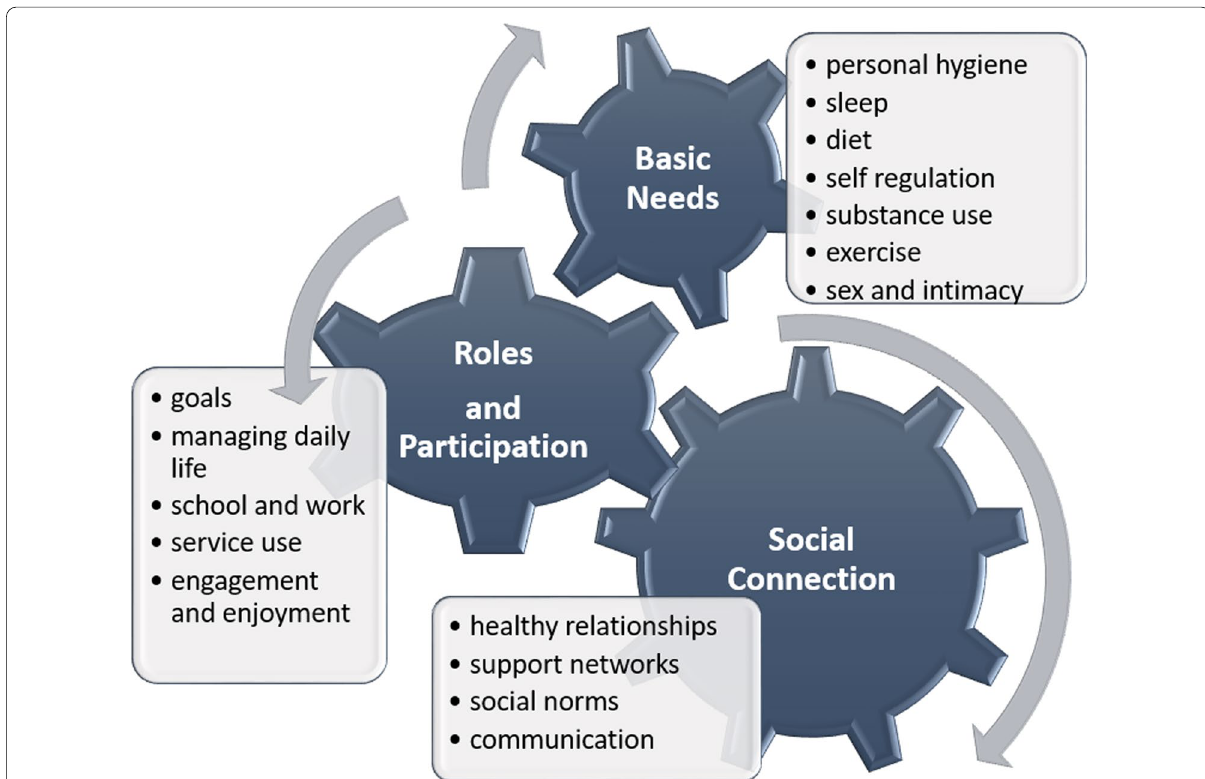
Fig. 3 Depiction of conceptualization of function from the perspective of young adults with mental health challenges accessing integrated youth health services in an urban setting. The model has three integrated parts: (1) basic needs, (2) roles and participation, and (3) social